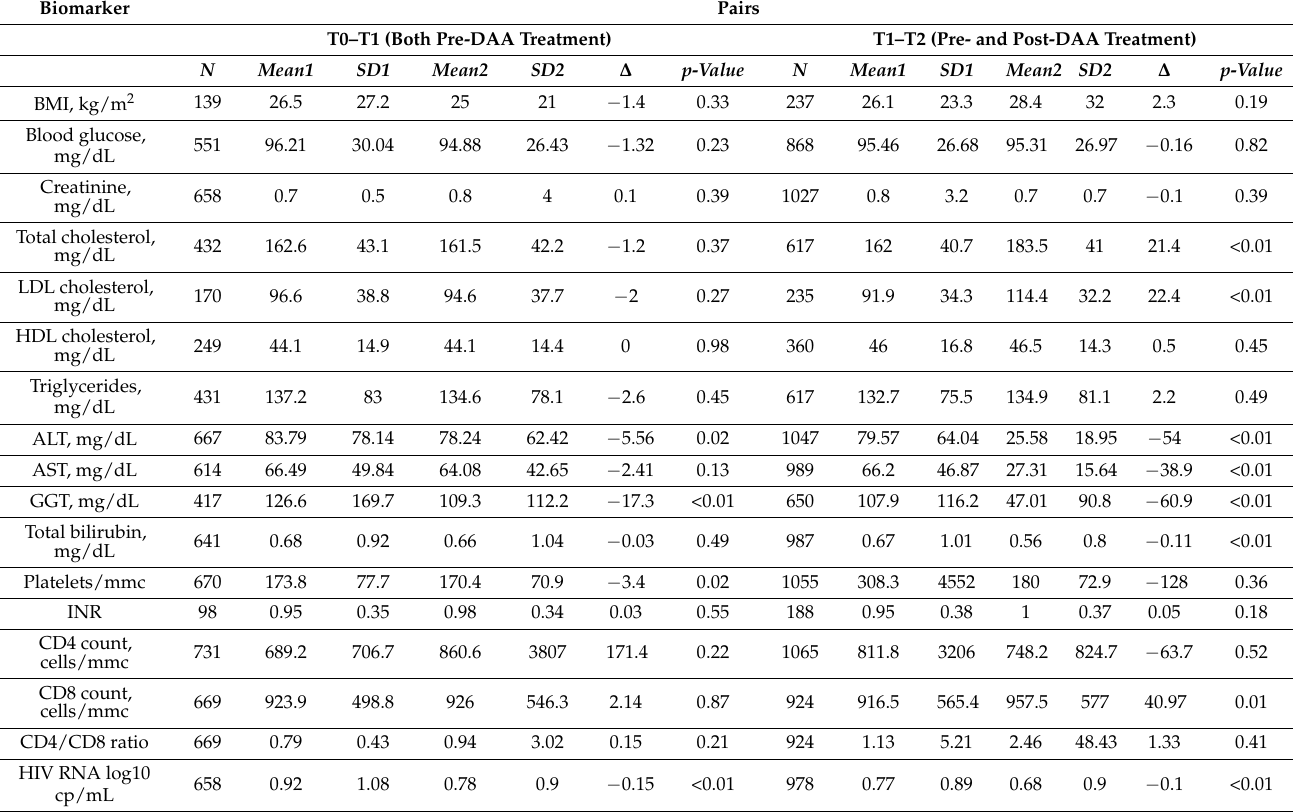
Table 3. Unadjusted pair analyses for all biomarkers. BMI: body mass index; LDL: low-density lipoprotein cholesterol; HDL: high-density lipoprotein cholesterol; GGT: gamma-glutamyl transferase; and INR: international normalized ratio. Biomarker